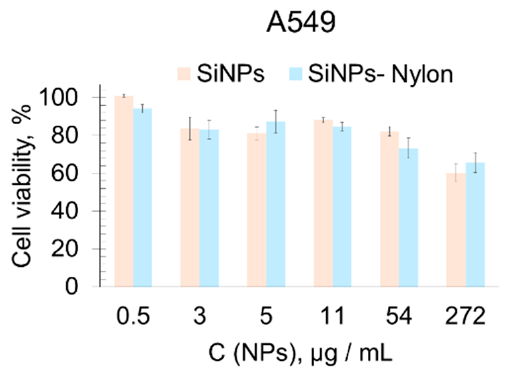
Figure 6. Cell viability assay (MTT test). A549 cell lines were incubated for 48 h with SiNPs (size 63 ± 1 nm by DLS) and SiNPs-Nylon (size 110 ± 2 nm by DLS). Cells treated with medium-supplemented PBS buffer instead of the nanoparticles’ solution were used as a 100% viability control. All values are given as the mean ± standard deviation (SD) values. All measurements were repeated not less than three times.